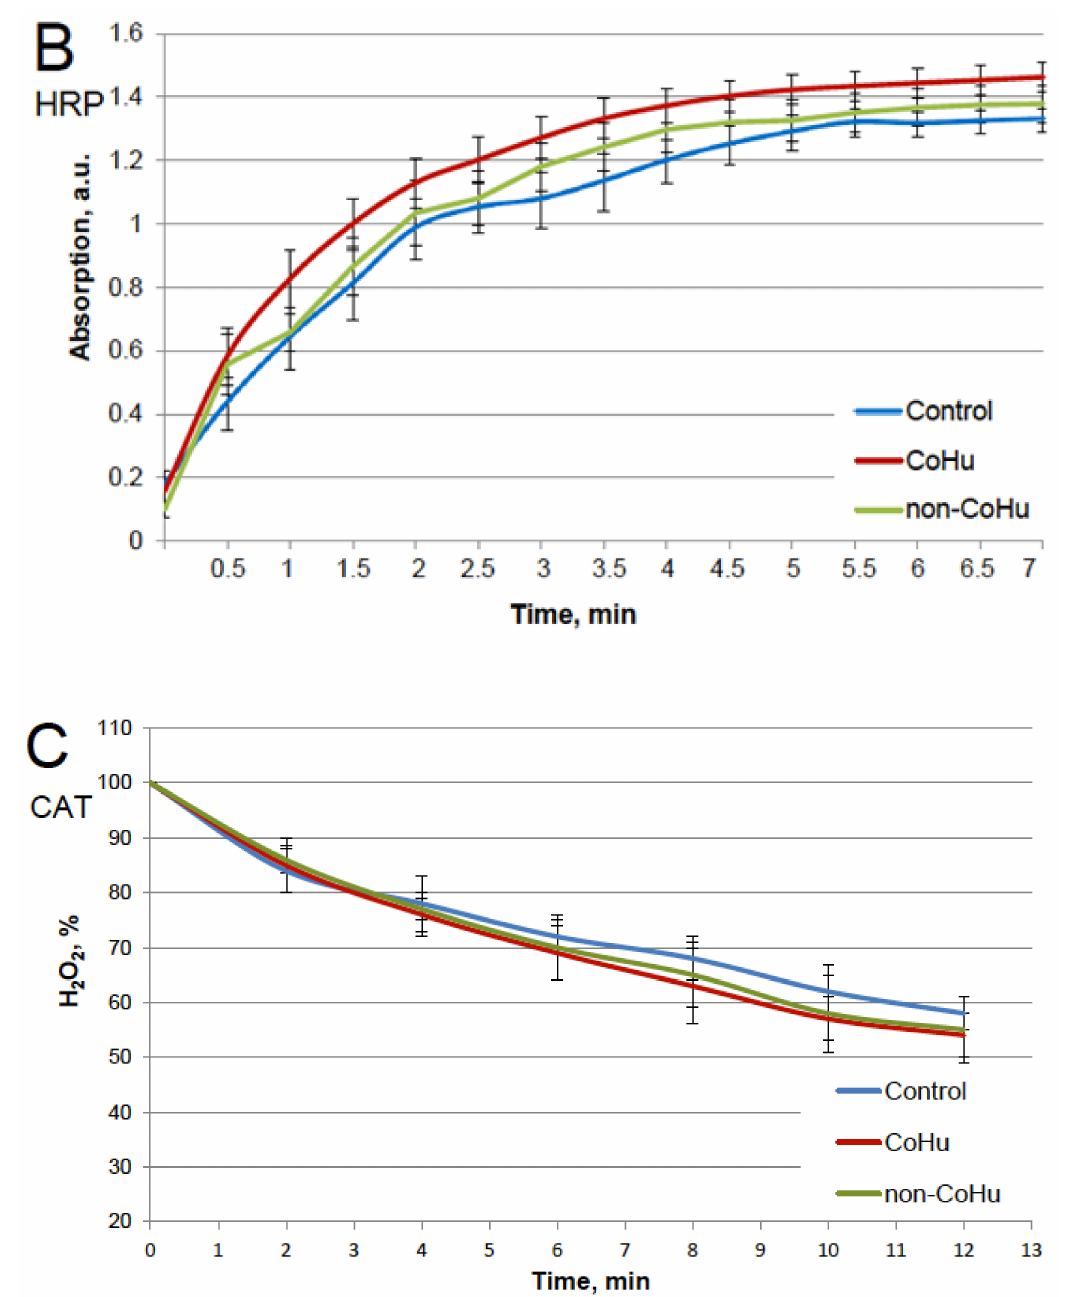
Figure 1. Effect of CoHu on alkaline phosphatase (( A ), AP), HRP ( B ) and catalase (( C ), CAT) activity in vitro. Data presented as mean arbitrary units of 7–8 measurements ± SD. Control—the activity of enzymes samples that were not treated with humid airstram. CoHu—the activity of enzymes that were treated with CoHu, and non-CoHu—the activity in control